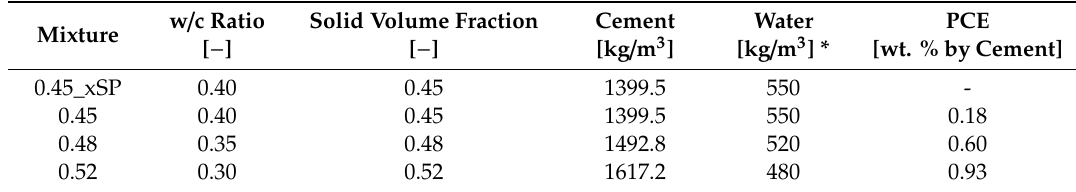
Table 1. Cement paste mixtures.